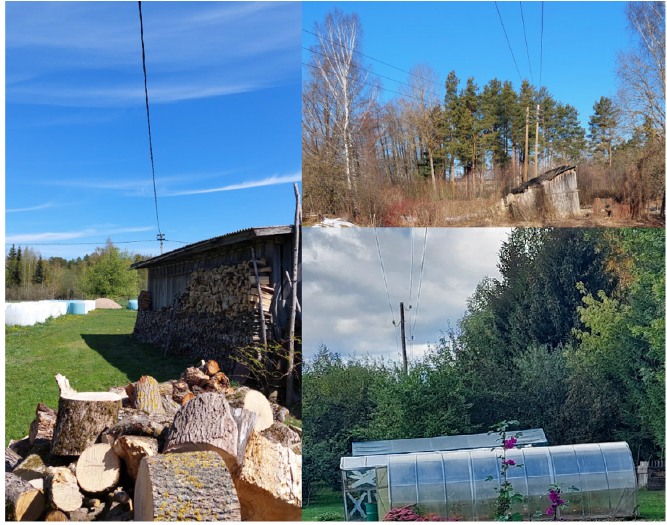
Figure 9. Violations of infrastructure protection zones.